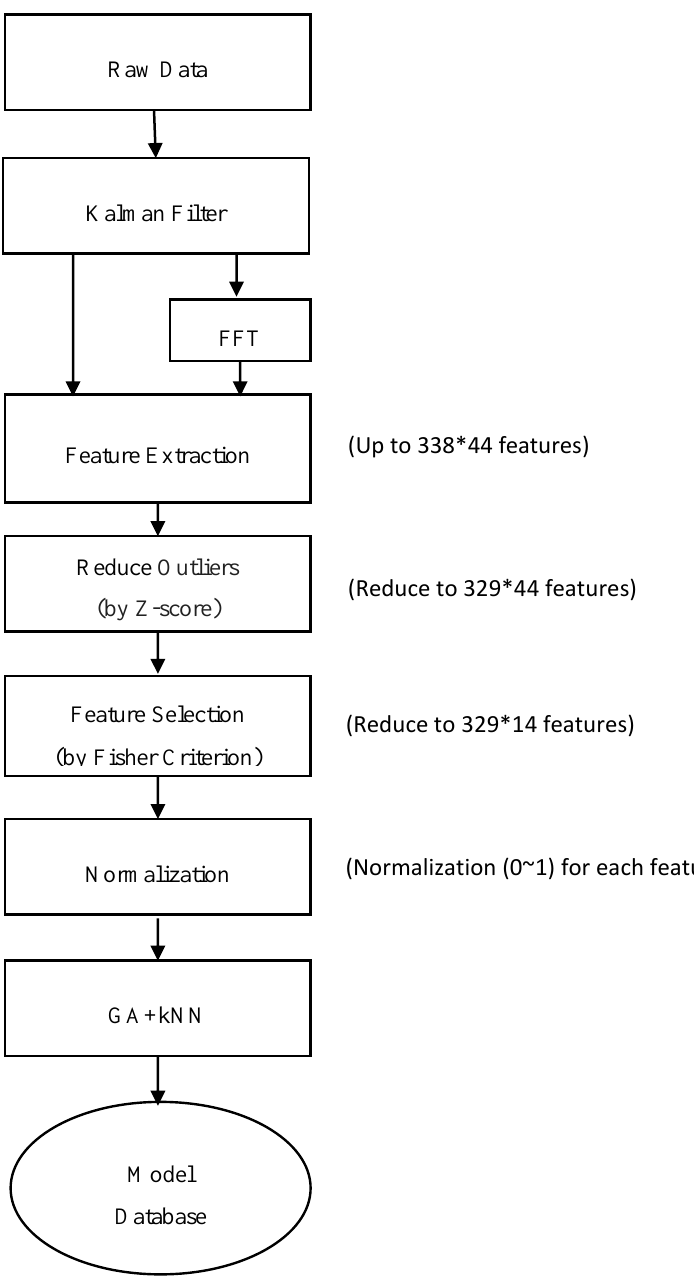
Figure 9. Flow chart of prognostic diagnosis based on feature extraction and the genetic algorithm/k-nearest neighbor (GA/KNN) classifier model.